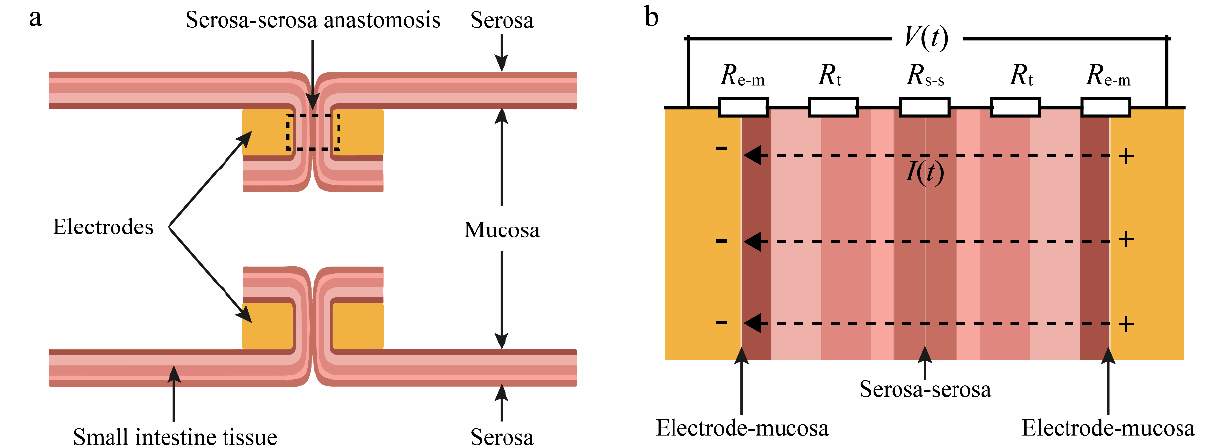
Figure 3. ( a ) Schematic diagram of the axial section in the welding area. The small intestinal mucosa comes into contact with the electrode, and the two serosa layers come into contact. ( b ) Impedance distribution between electrodes. The impedance value measured between the electrodes is the total of twice the electrode’s contact impedance to the mucosal layer R e − m , the contact impedance of double serosa layers R s − s , and twice the impedance of the small intestinal tissue itself R t . Changes in electrode spacing and small intestine thickness influence contact impedance, whereas changes in temperature, moisture, and collagen influence tissue